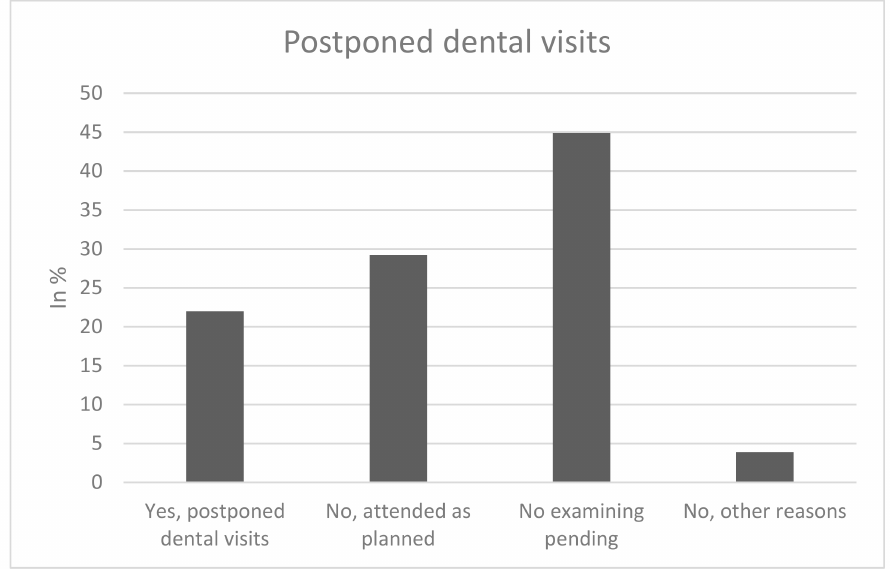
Figure 1. Postponed dental